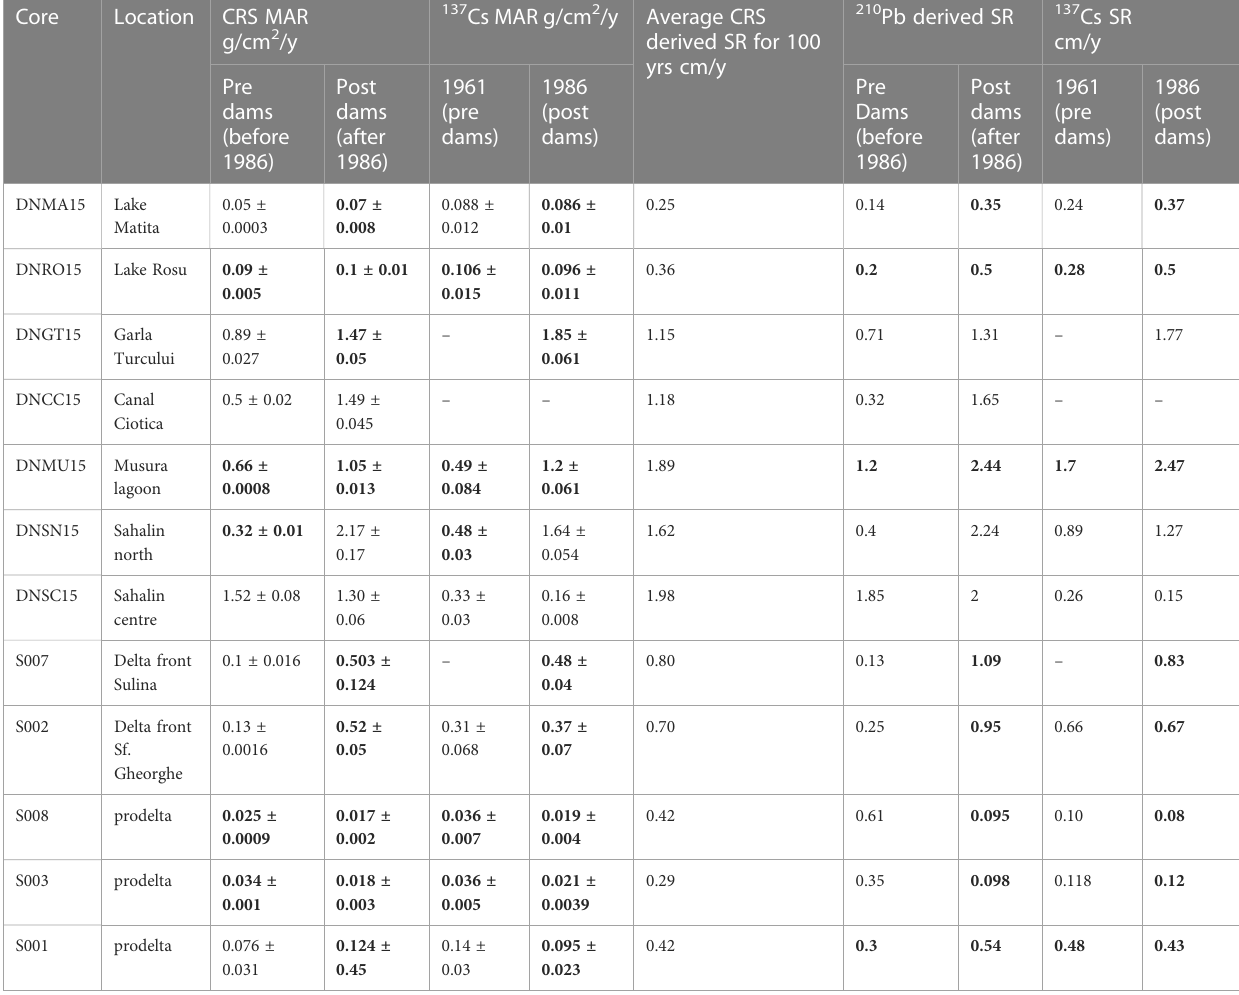
TABLE 2 Average mass accumulation rates (MAR) and sedimentation rates (SR), calculated based on 210 Pb and 137 Cs